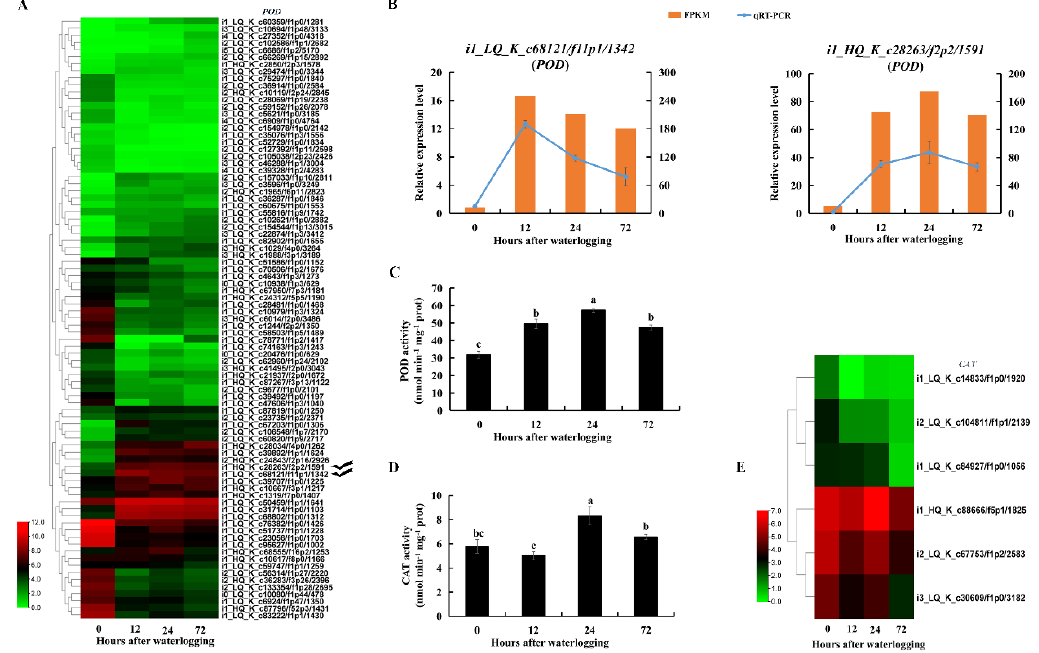
Figure 11. Changes in contents of hydrogen peroxide and superoxide anion and activities of perox- idase (POD) and catalase (CAT) and expression patterns of PODs and CATs in KR5 roots under waterlogging stress. ( A ) transcript levels of PODs ; ( B ) RNA-Seq (right vertical axis) and qRT-PCR (left vertical axis) results for transcript changes in two PODs which were highly induced under wa- terlogging stress; ( C ) POD activity; ( D ) CAT activity; ( E ) transcript levels of CATs . In ( C , D ) data are expressed as averages ± SD, n = 3 and significant differences between treatments at p < 0.05 are indicated by different letters over columns (Duncan’s test).